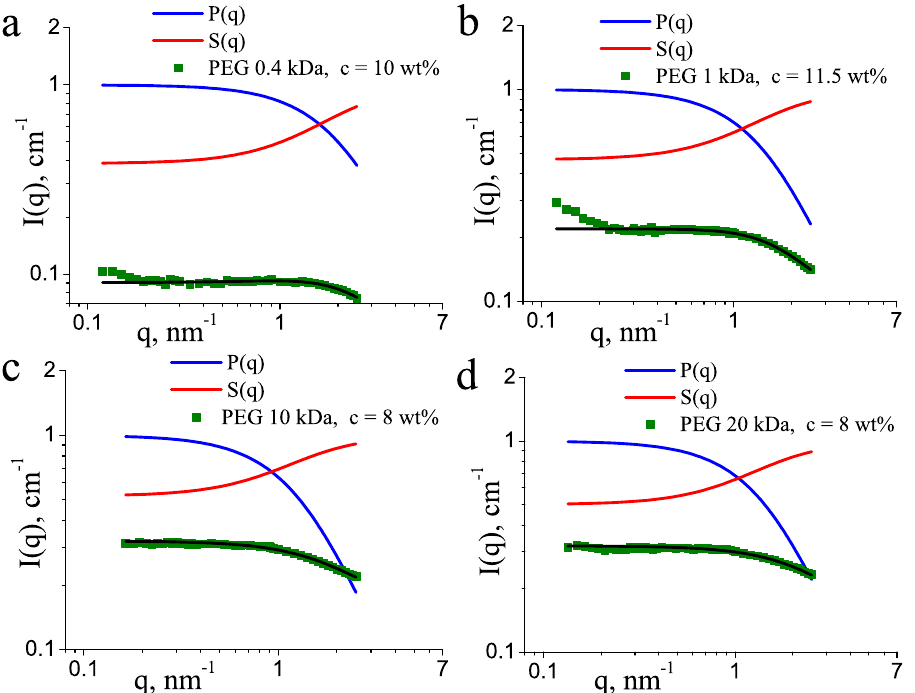
Figure 3. Form factors and structure factors for PEG of molecular mass ( a ) 0.4 kDa, ( b ) 1 kDa, ( c ) 10 kDa, ( d ) 20 kDa. The concentrations of PEG are indicated. The experimental scattering intensities (symbols) and the model fits (black lines) are displayed in absolute scale, while the form and structure factors are normalized as P ( 0 ) = 1, and S ( ∞ ) = 1.